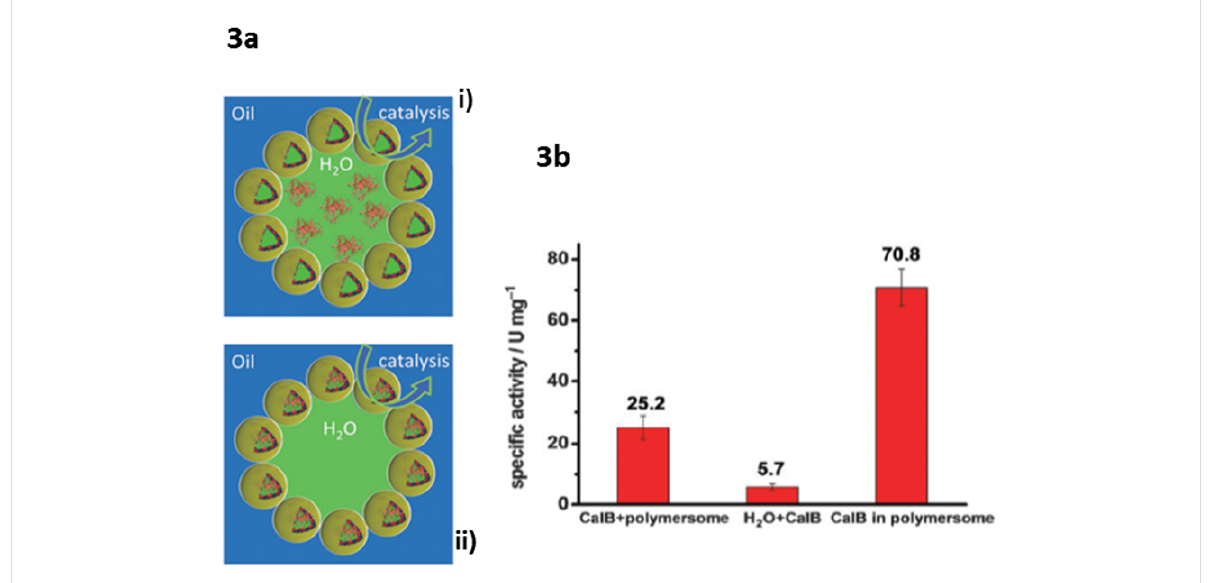
Figure 3: 3a) Schematic representation of a Pickering emulsion with the enzyme in the water phase (i), or with the enzyme inside the polymersome lumen (ii). 3b) Chart of the specific activities of CalB dissolved in the water phase of the polymersome Pickering emulsion (left), CalB in a biphasic water/toluene system (middle,) and CalB encapsulated in the lumen of the polymersome Pickering emulsion (right). Adapted with permission from